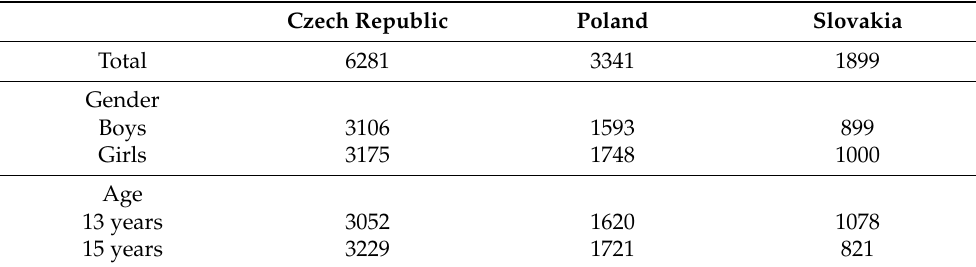
Table 1. Sample characteristics ( N = 11,521).